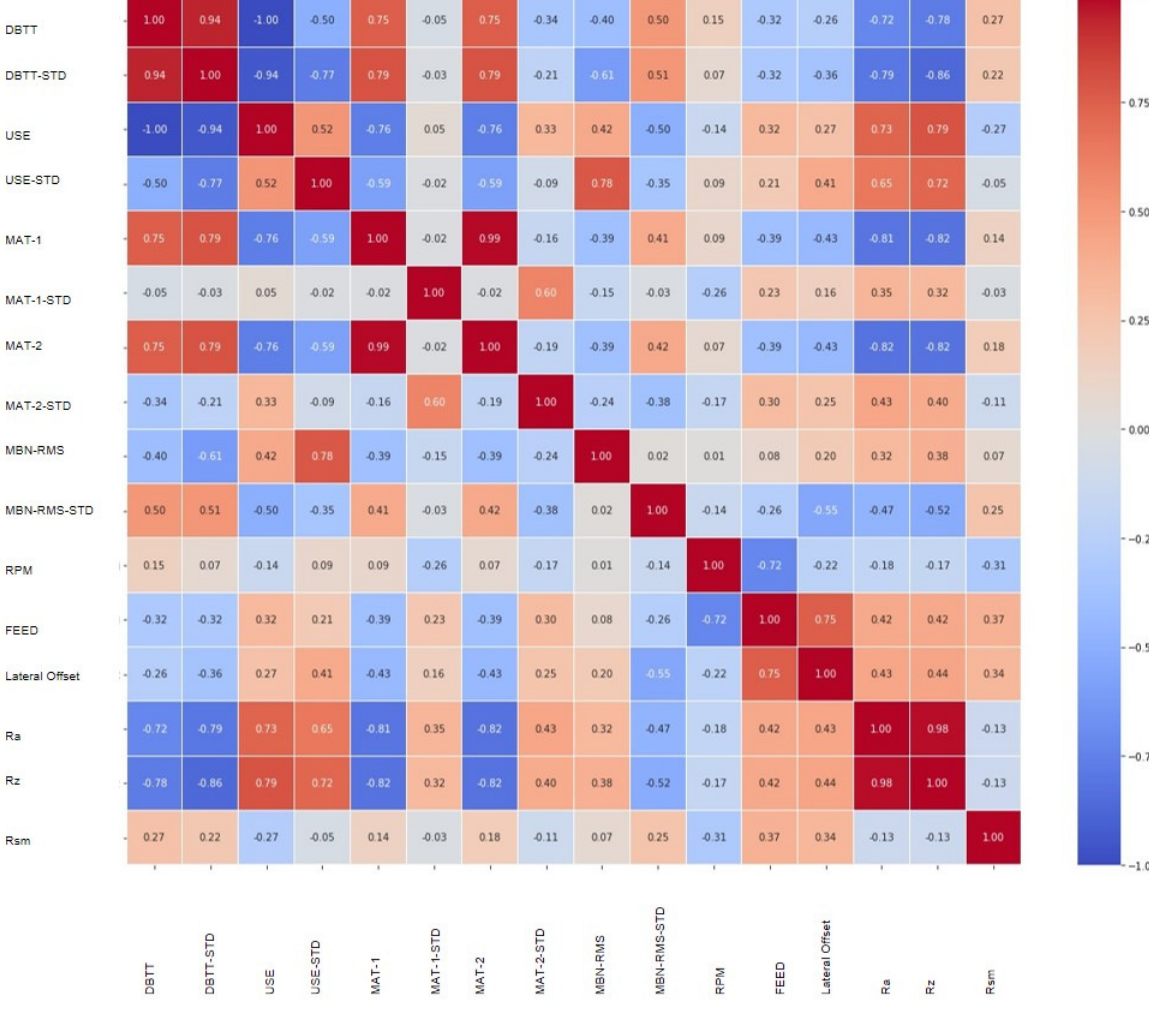
Figure 10. RRT4 (predicted) Correlation Heat-map.